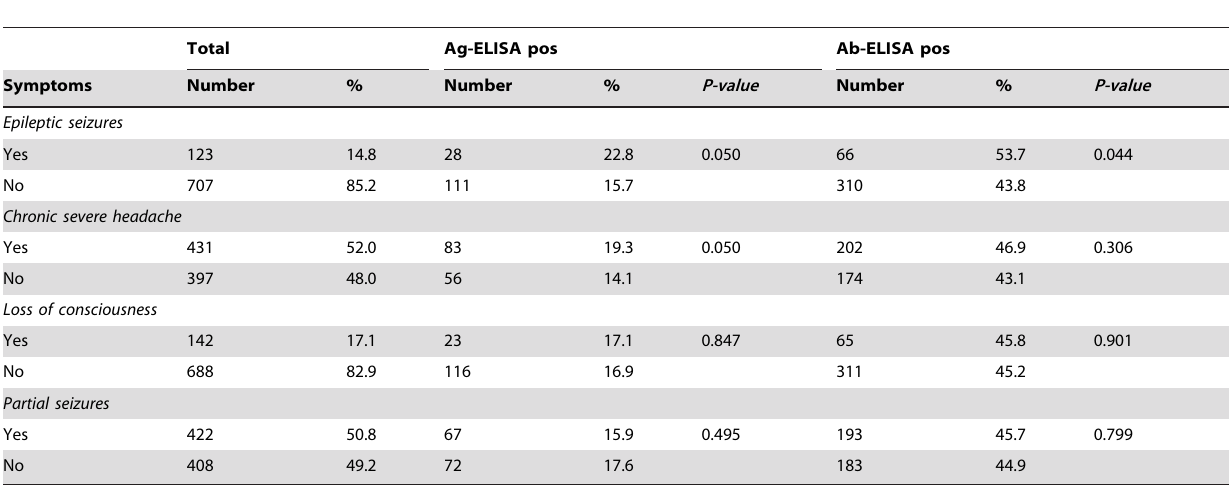
Table 2. Associations between reported neurological symptoms and T. solium positivity (Ag- and Ab-ELISA), Mbozi district,